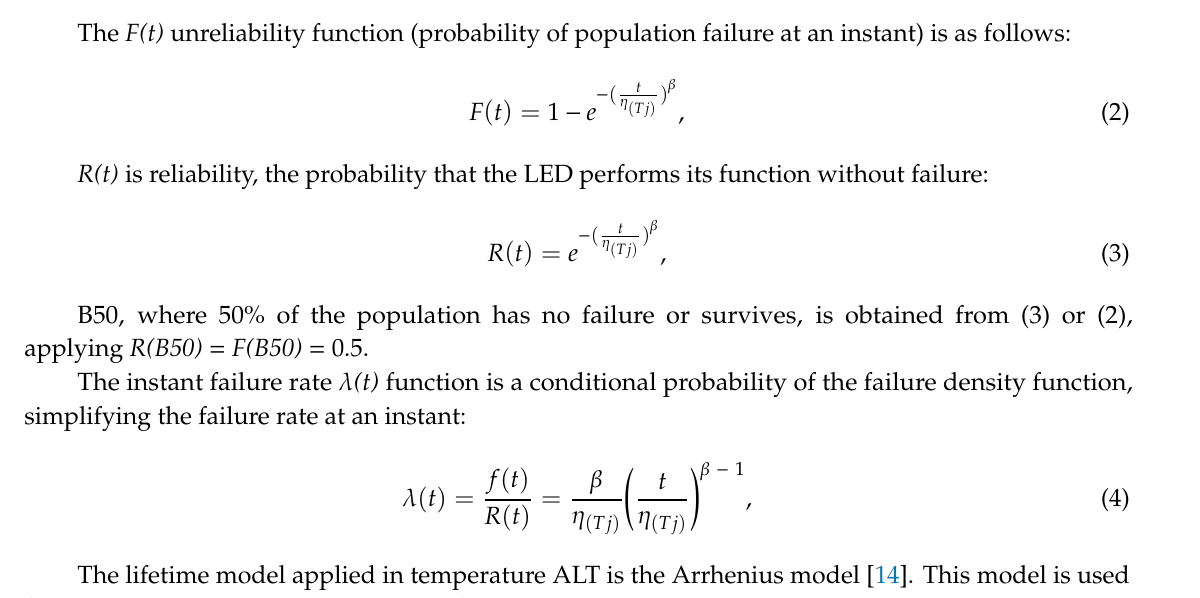
Figure 4. f(t) probability density function of tested LEDs in three T a ALTs and two working conditions, indicated by gray areas. Evolution of η (Ta) Weibull parameter for continuous working indicated by the green line, and η (Ta) for cycled working (30 s on / 30 s of) by the red line. Identification of η (Ta) at T a = 25 and 40 °C indicated by vertical dashed black lines.